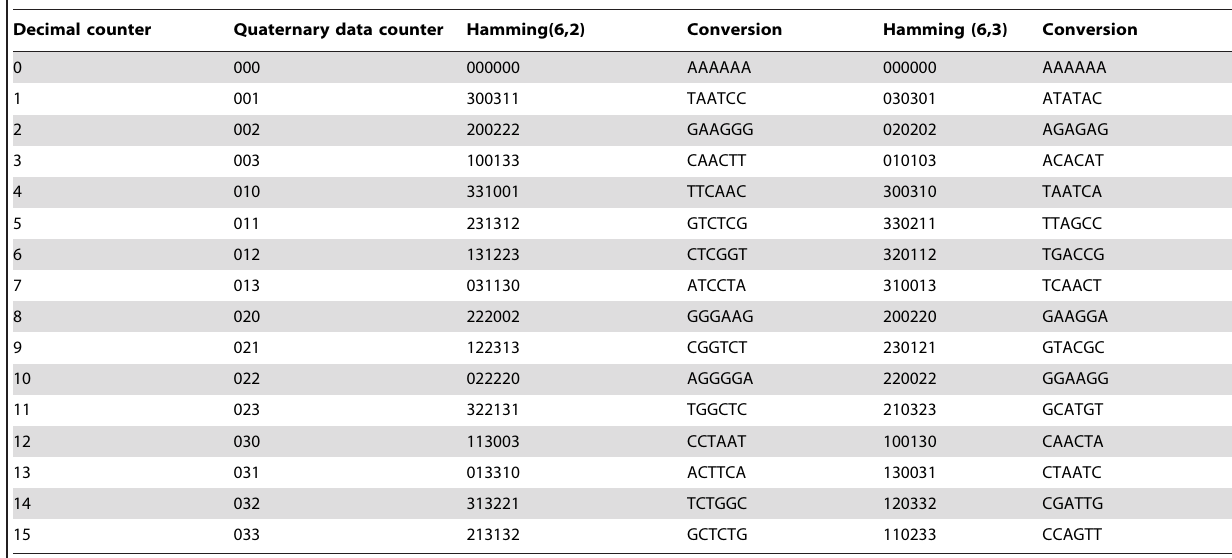
Table 3. Examples of quaternary Hamming encoded barcode sequences.